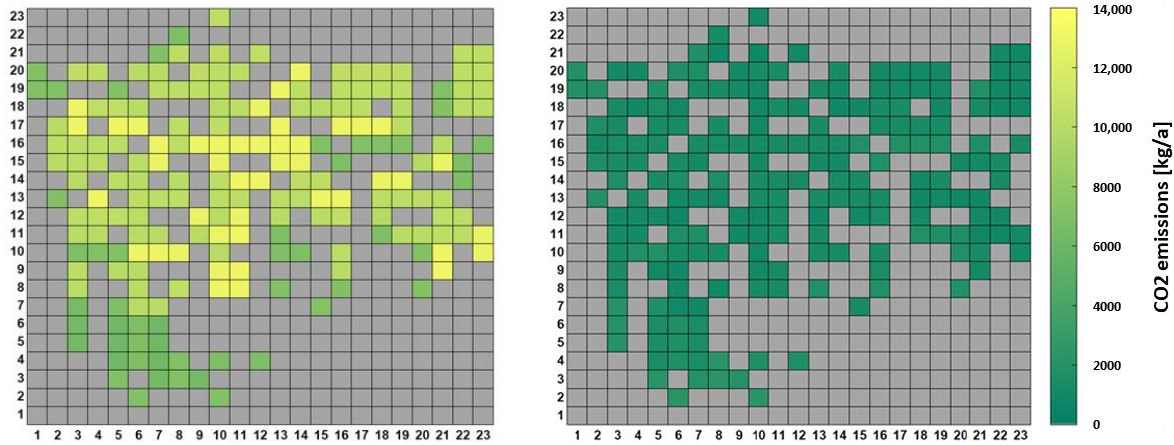
Figure 8. CO 2 emission maps for the Smulsko cluster before (on left ) and after (on right ) modernization. Table 2. An energy-related summary for the Smulsko cluster.